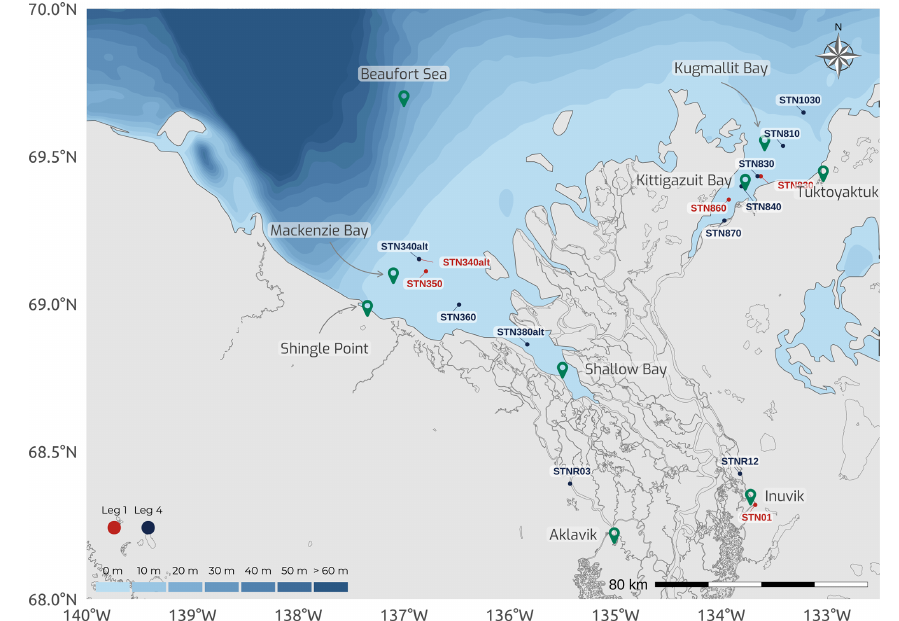
Figure 12. Map of the Mackenzie Delta region (Inuvialuit Settlement Region, Northwest Territories, Canada), with bathymetric features of the coastal waters of the southern Beaufort Sea, showing the locations for the sediment and pore water sampling during two legs of the 2019 WP4 Nunataryuk field expeditions (Legs 1 and